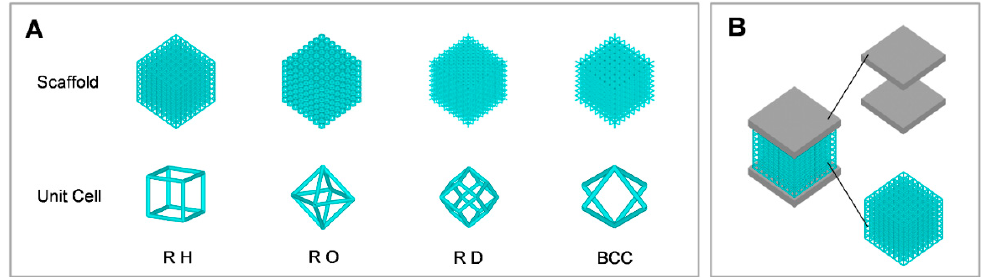
Figure 1. Design of porous scaffolds. ( A ) Configurations for four porous scaffolds. ( B ) Sample assembly of a porous scaffold (cyan) and compressed substrates (gray).